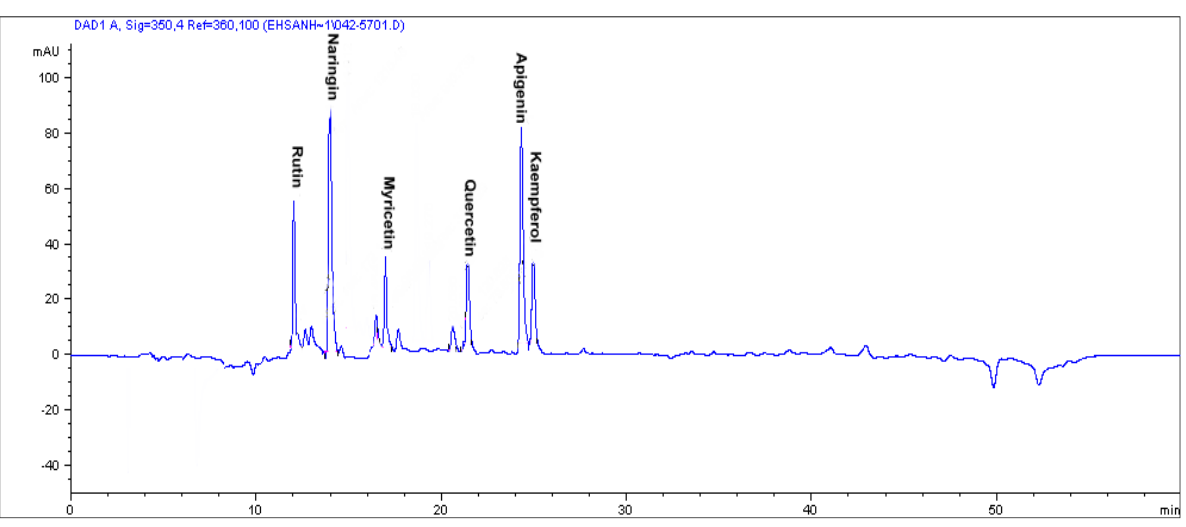
Figure 1. The RP-HPLC chromatogram of flavonoid compounds in the leaves of Labisia pumila var. pumila. Identification of compounds: rutin, naringin, myricetin, quercetin, apigenin and kaempferol .